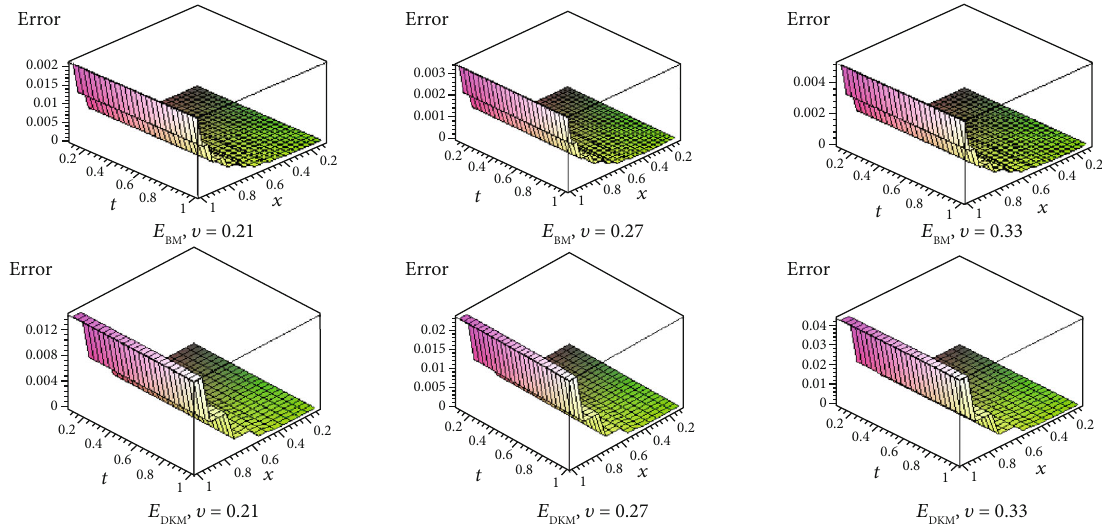
Figure 3: The values of errors by B-by-BM and DKM at T = 1 , N = 10 , and k = 1 for υ = 0 : 21, 0 : 27, 0 : 33 .